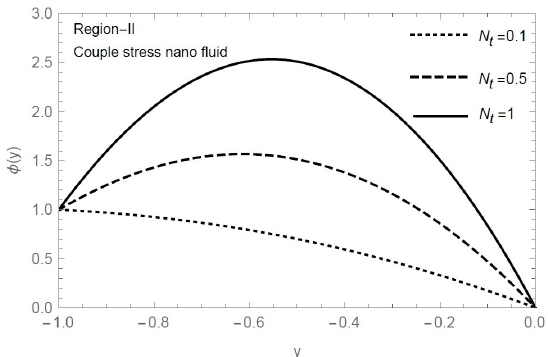
Figure 6: The influence of thermophoretic parameter N t on mass transfer keeping λ 1 = 50, Pr i = 2, h = 1, ξ i = 0.01, Γ i = δ i = 0.1, N b = 0.01 and µ = K = 0.5 .